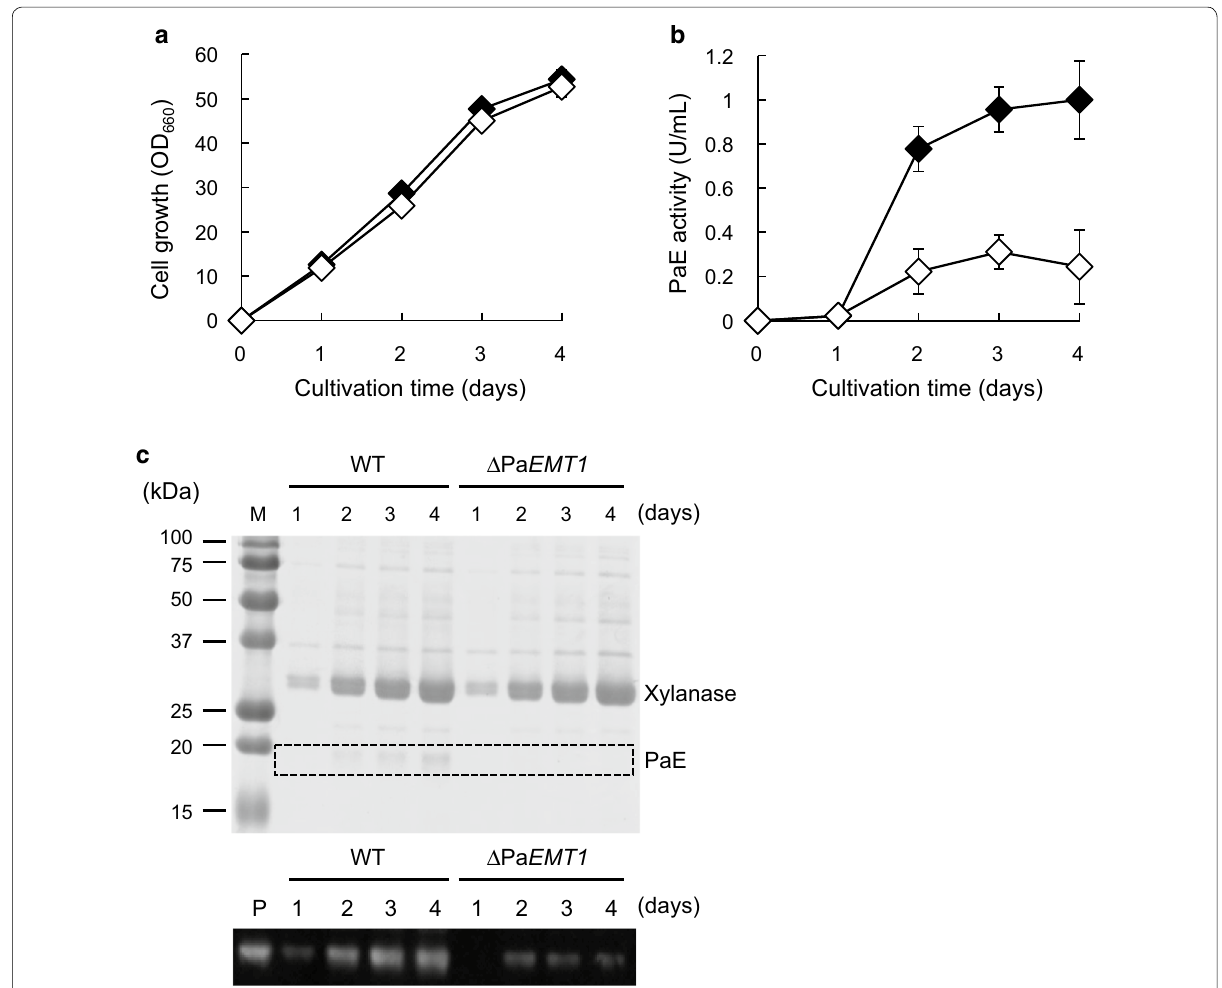
Fig. 2 Time course of PaE production by strain ∆Pa EMT1 in m -3 FMM (fungal minimum medium) supplemented with 8% xylose. a Cell growth × of wild-type (closed diamonds) and ∆Pa EMT1 (open diamonds). b Plastic-degrading enzyme (PaE) activity of wild-type (closed diamonds) and ∆Pa EMT1 (open diamonds). c sodium dodecyl sulfate polyacrylamide gel electrophoresis (SDS-PAGE) and PaE detection through western blot analysis of culture supernatants of wild-type and ∆Pa EMT1. M, marker; P, purified PaE loaded as a standard. The amount of each culture supernatant loaded in the gel was 10 μL for Coomassie brilliant blue (CBB) staining and western blotting. The results of the cell growth and PaE activity assays are shown as the average of three different experiments. Error bars show standard